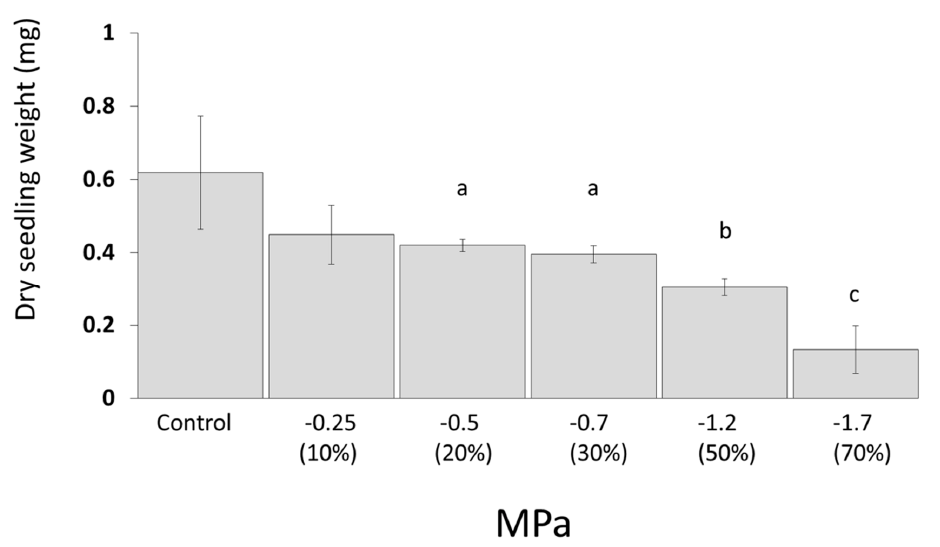
Figure 1. The effect of reducing water activity on B. napus L. total biomass after 7 days of